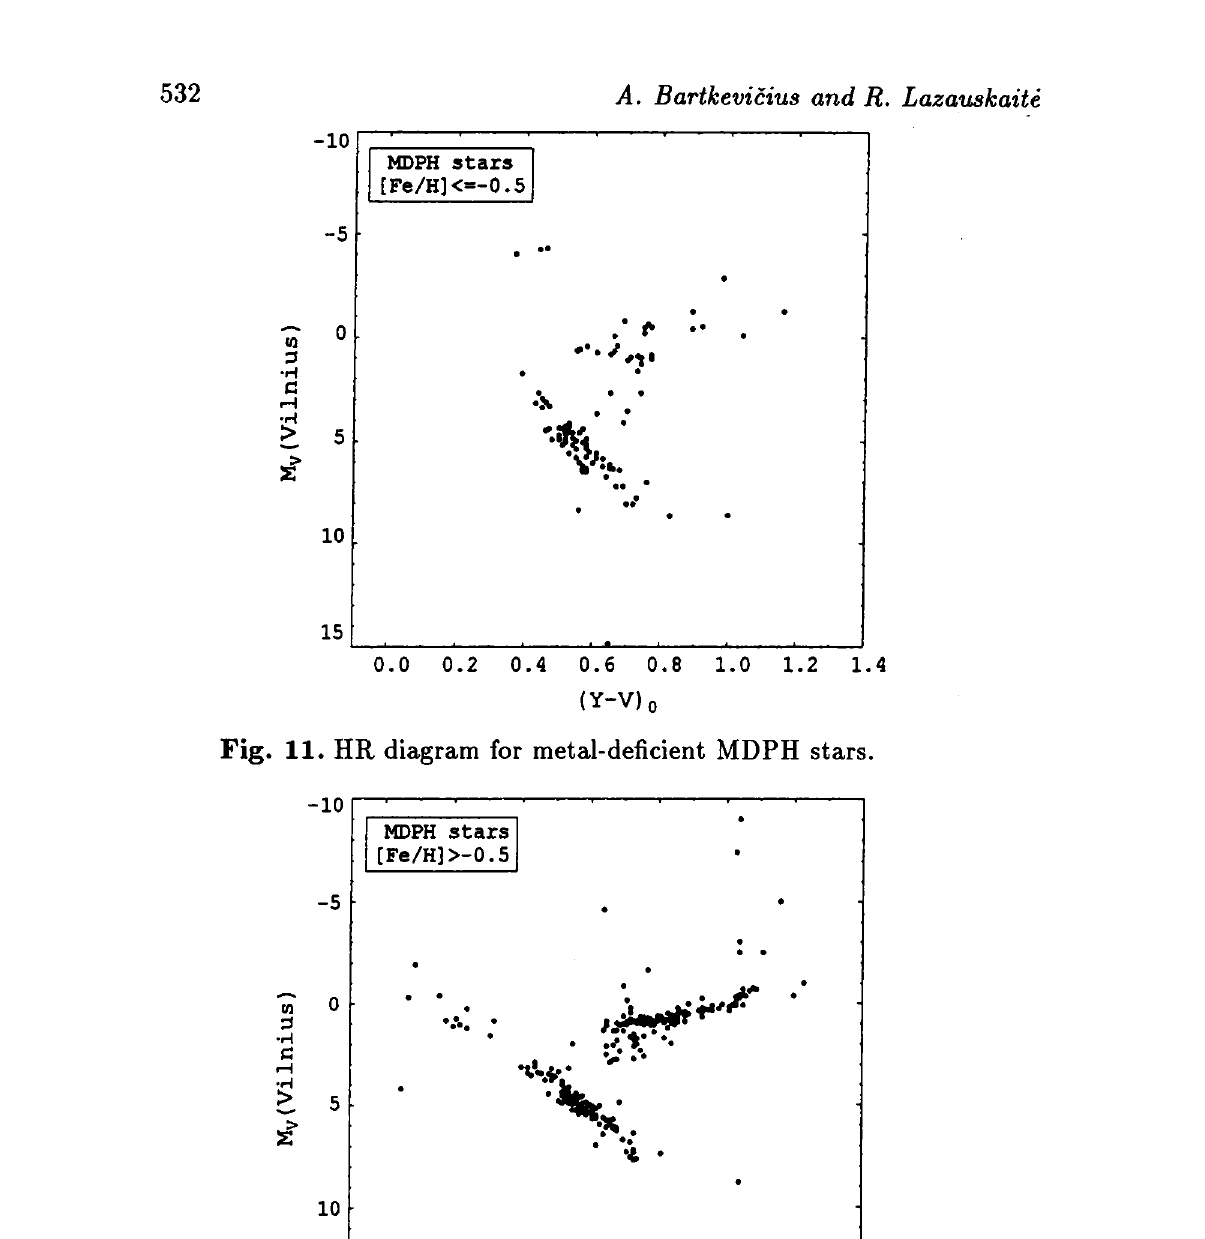
Fig. 12. HR diagram for MDPH stars of normal chemical composi-